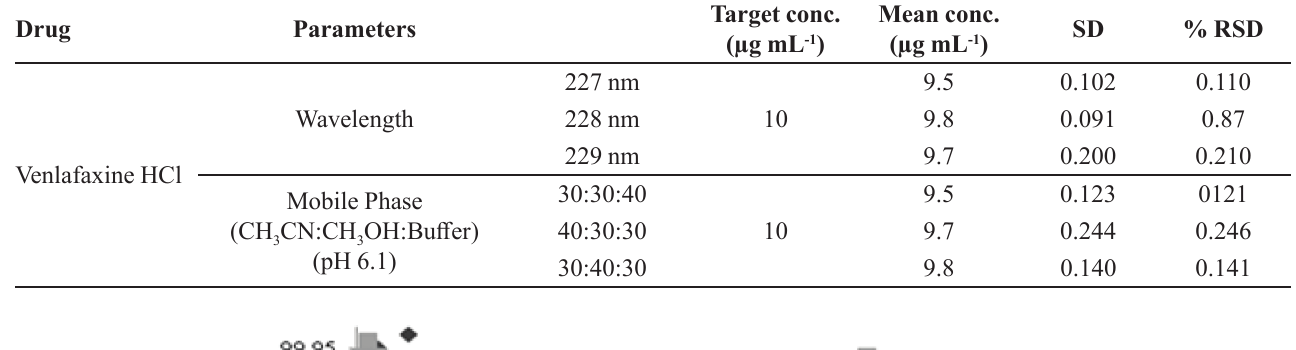
TABLE V - Robustness of HPLC-UV method Drug